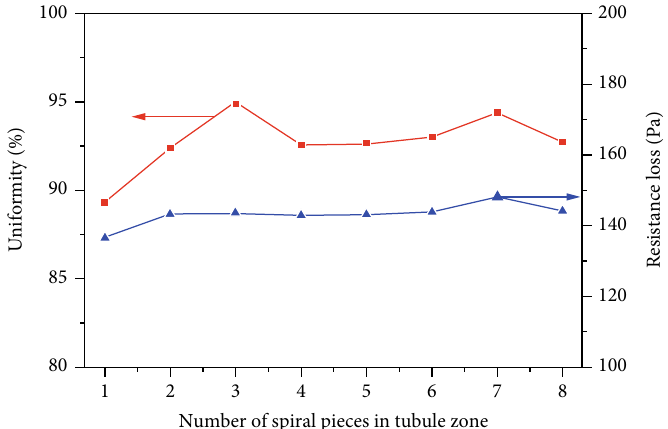
Number of spiral pieces in tubule zone Figure 10: In fl uence of the number of spiral blades in the tubular zone on fl ow parameters.